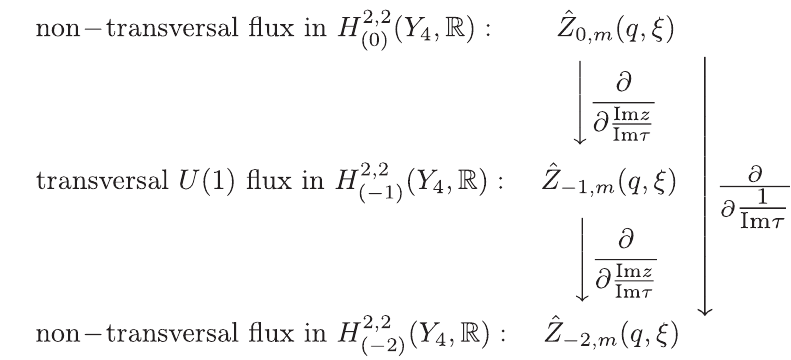
Figure 1 . A sketch of the interplay between elliptic holomorphic anomalies and (almost holo- morphic) partition functions, ˆ Z w,m ( q, ξ ) , pertaining to the various fluxes as classified in (2.17). Here ˆ Z − 1 ,m ( q, ξ ) is (the non-holomorphic cousin of) the elliptic genus in four dimensions. More- over ˆ Z − 2 ,m ( q, ξ ) encodes relative invariants of certain embedded threefolds Y i formally, be associated to elliptic genera in six